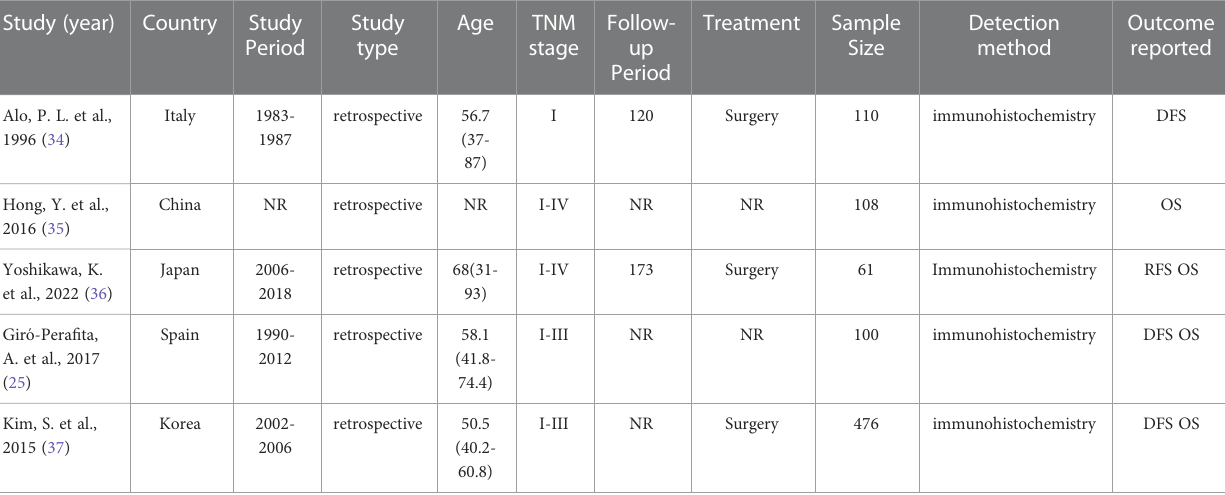
TABLE 1 Baseline characteristics of included